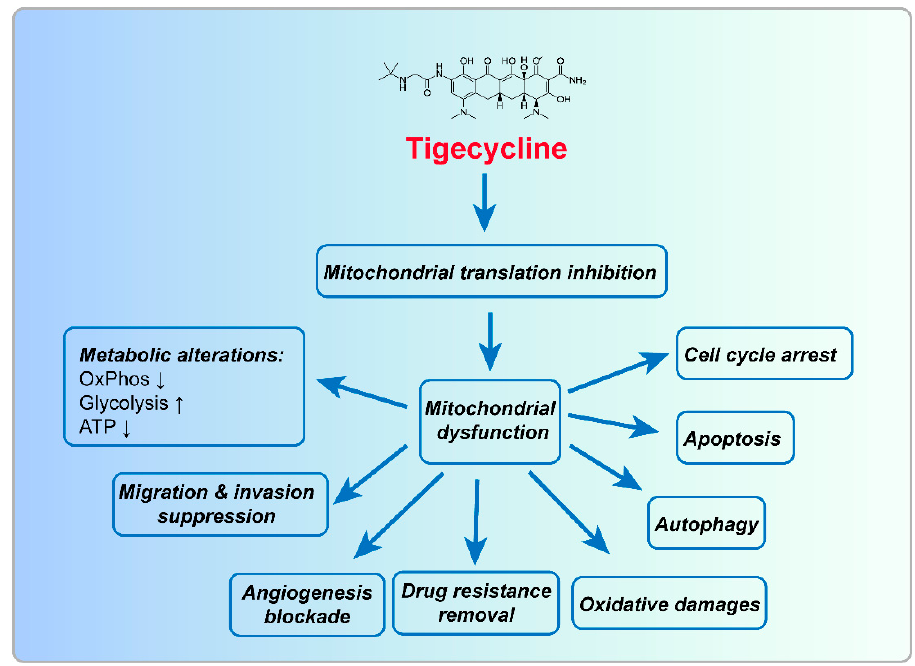
Figure 5. Hypothesis on the causality of phenotypes induced by tigecycline treatment in cancer cells.